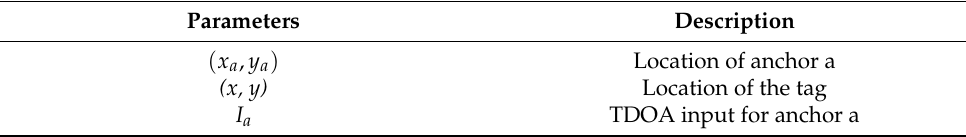
Table 1. Parameters of the objective